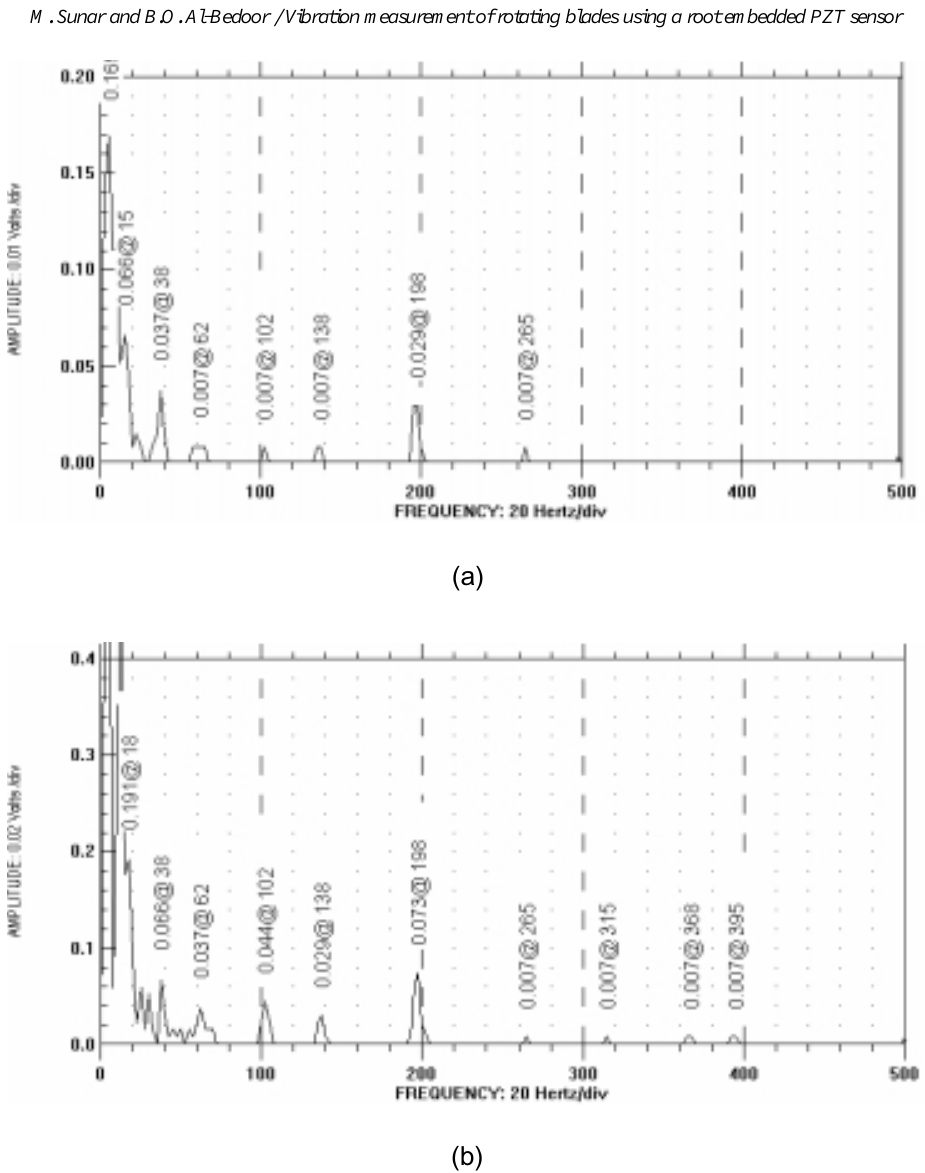
Fig. 32. Frequency spectrums of the steady-state vibrations of the system rotating at speed of 40 Hz: (a) Strain gages, (b) PZT material. is shown for the 1X (20 Hz) frequency component related to the imbalance. The 2X (40 Hz) component can